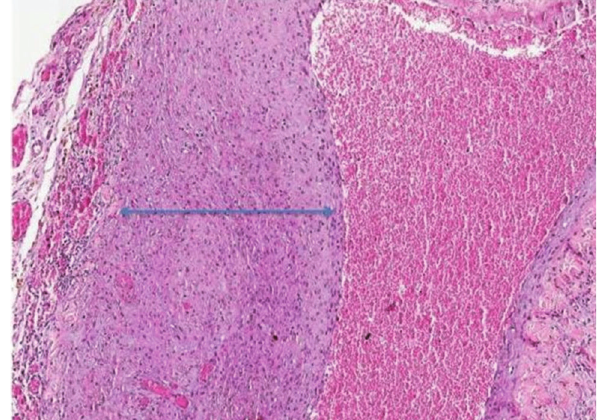
Figure 2 - Slide showing strong intimal proliferation, which led to luminal stenosis (rat No. 24).